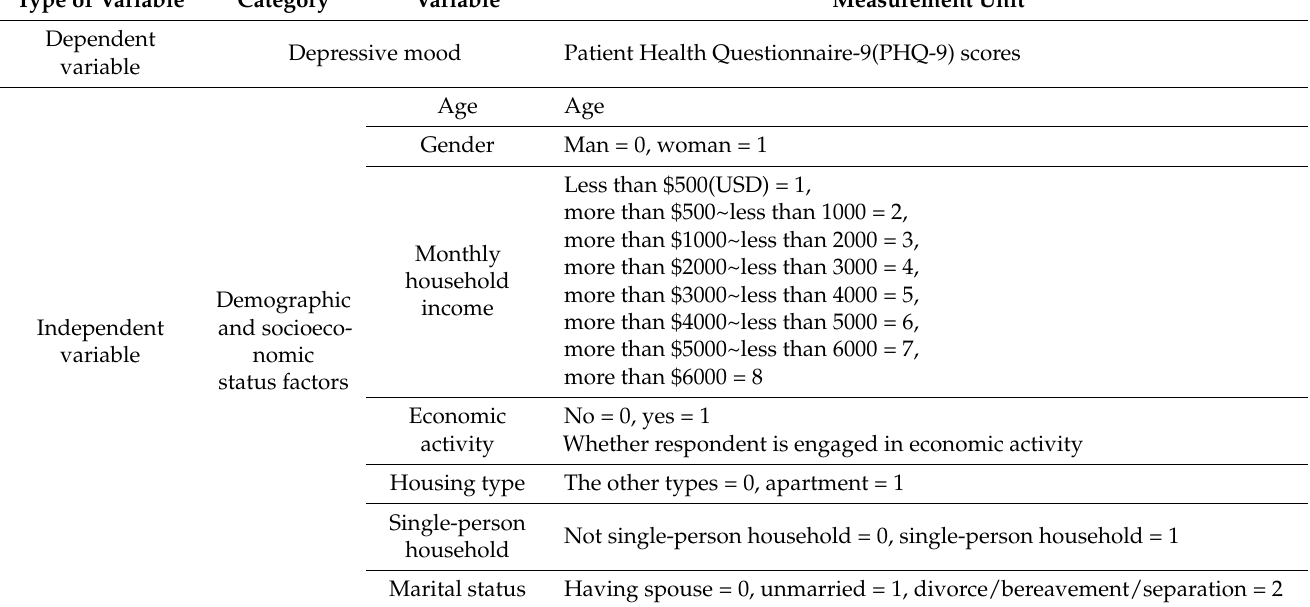
Table 1. Measured